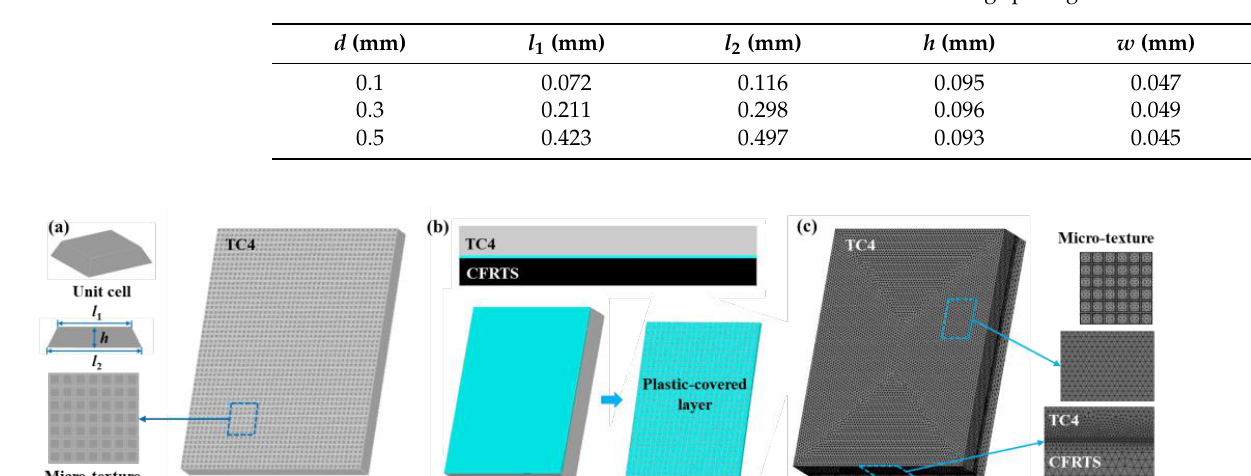
Figure 5. Surface morphology of TC4 alloy after laser micro-texturing: ( a ) d = 0.1 mm; ( b ) d = 0.3 mm; ( c ) d = 0.5 mm. Table 4. Measurement dimensions of micro-textures at different scanning spacings.